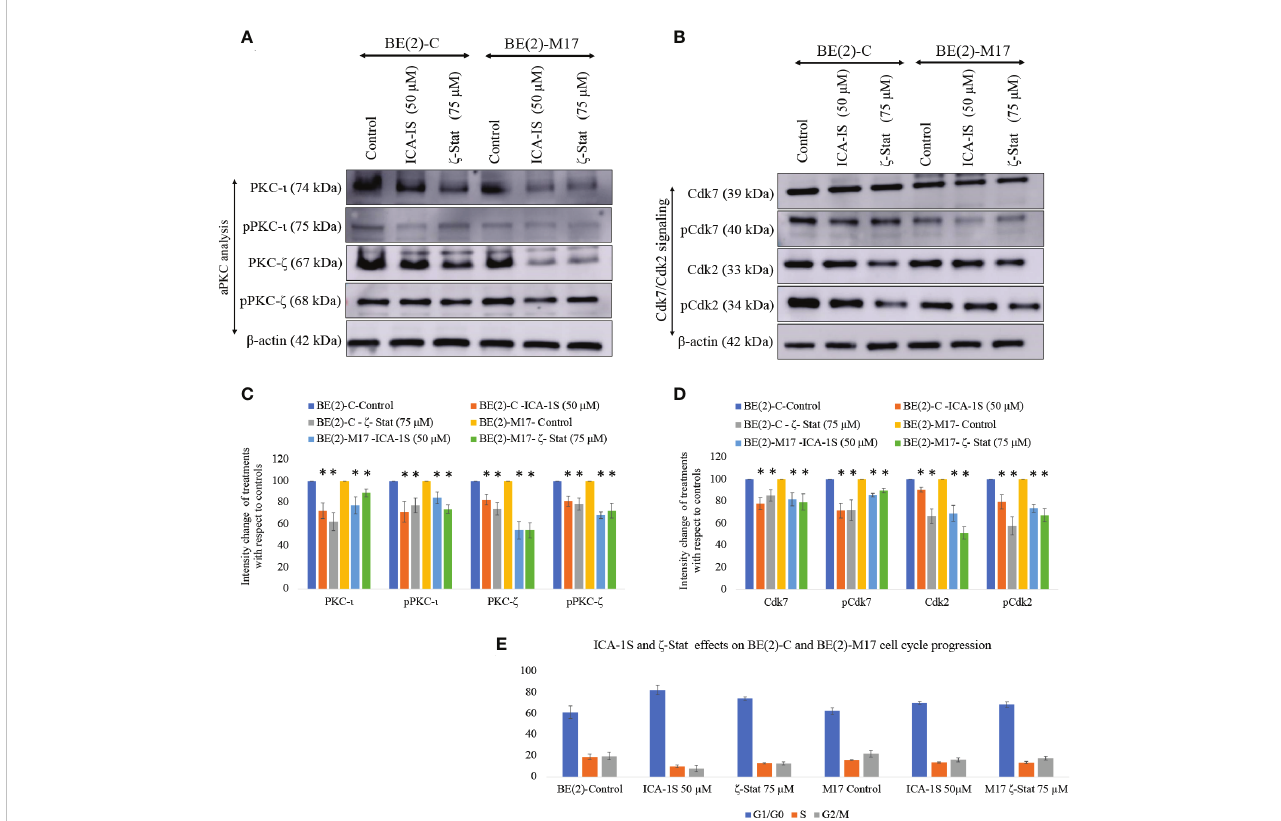
FIGURE 2 Effect of ICA-1S and z -Stat on aPKC expression and cell cycle in NB cells. (A) Western blots for protein expression levels of total PKC- i , phosphorylated PKC- i (T555), total PKC- z and phosphorylated PKC- z (T410). (B) Western blots for expression of Cdk7, phosphorylated Cdk7, Cdk2 and phosphorylated Cdk2 for the inhibitor treatments (50 µM of ICA-1S and 75 m M of z -Stat). Protein (60-80 µg) was loaded in to each well and b -actin was used as the housekeeping marker in each Western blot. (C) Densitometry bar graph for Western blots in A). (D) Densitometry bar graph for Western blots in B). (E) Flow cytometric cell cycle analysis demonstrates the percentage of different cell cycle phases on NB cells for ICA-1S and z -Stat treatments. Experiments ( N = 3) were performed and representative bands are shown. Graphs depict percentage change of treated samples with respect to their controls and mean ± SD are plotted. Statistical signi fi cance is indicated by asterisk as * P <